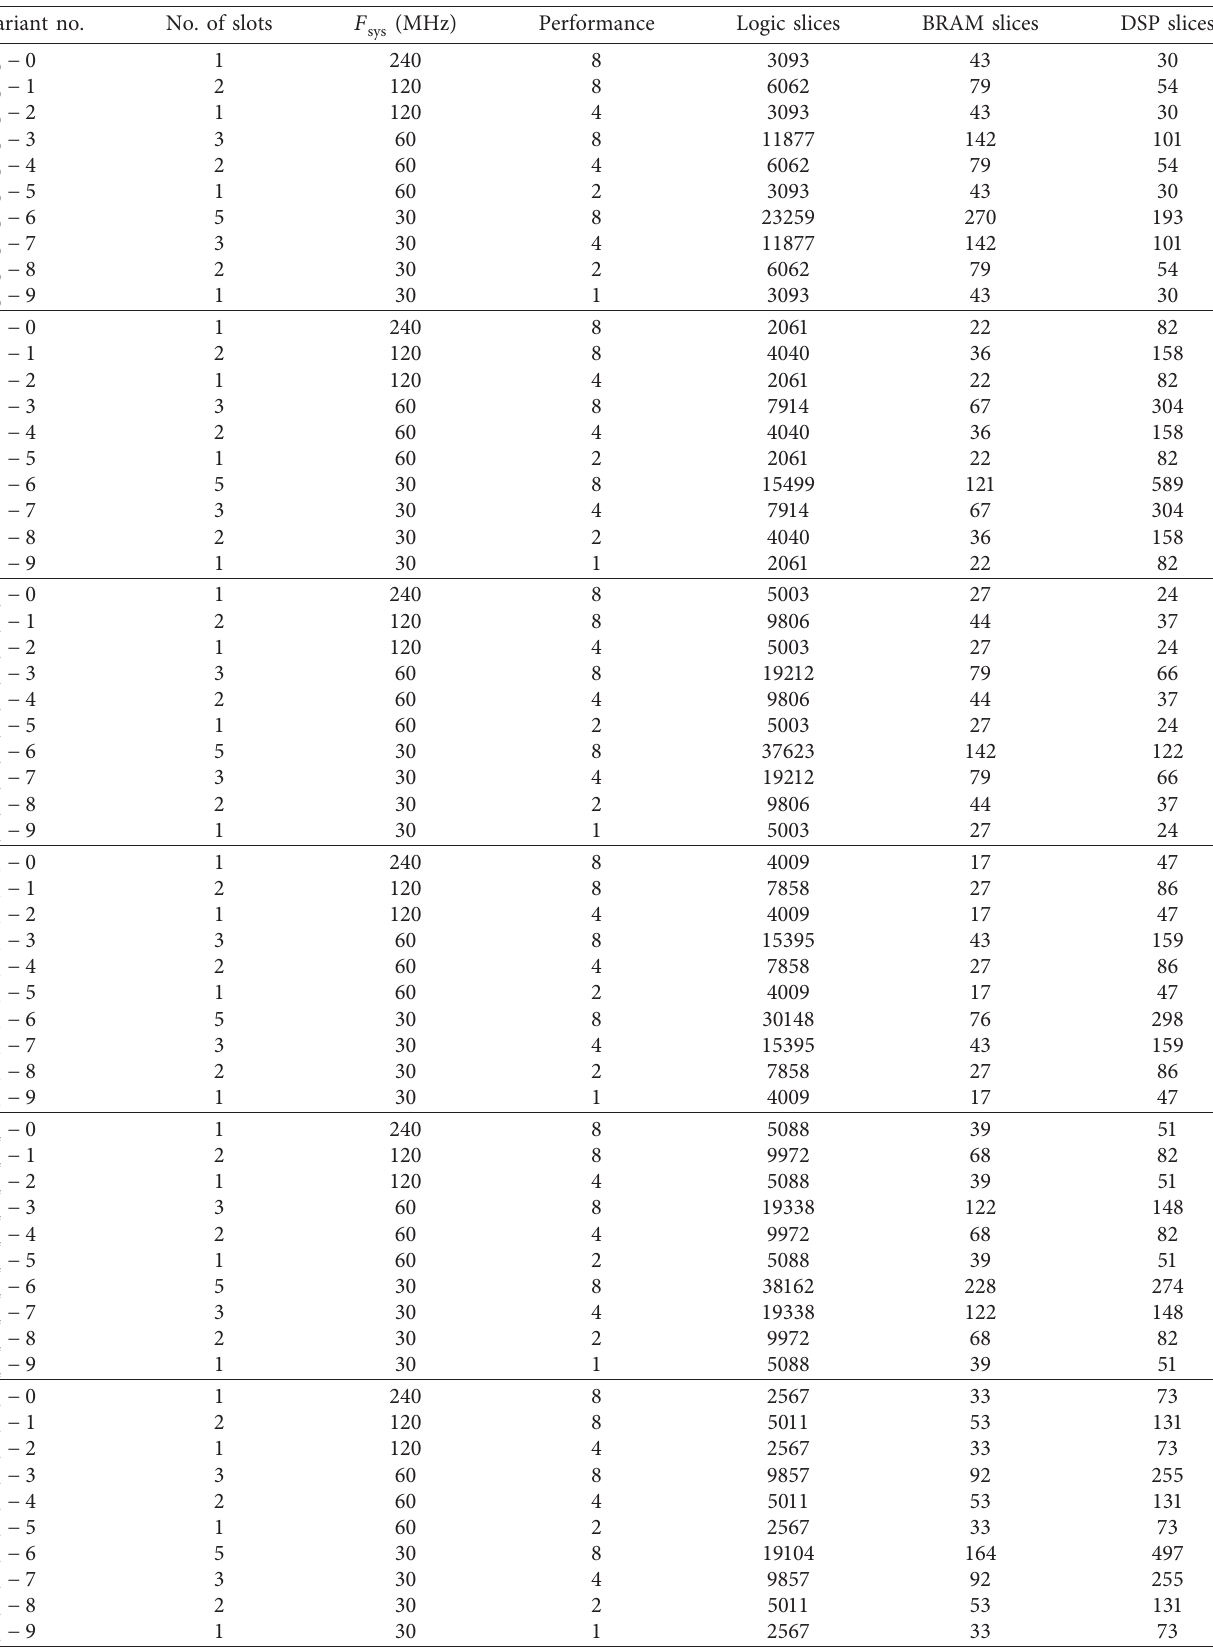
Table 2: An example of Variant-LUT for